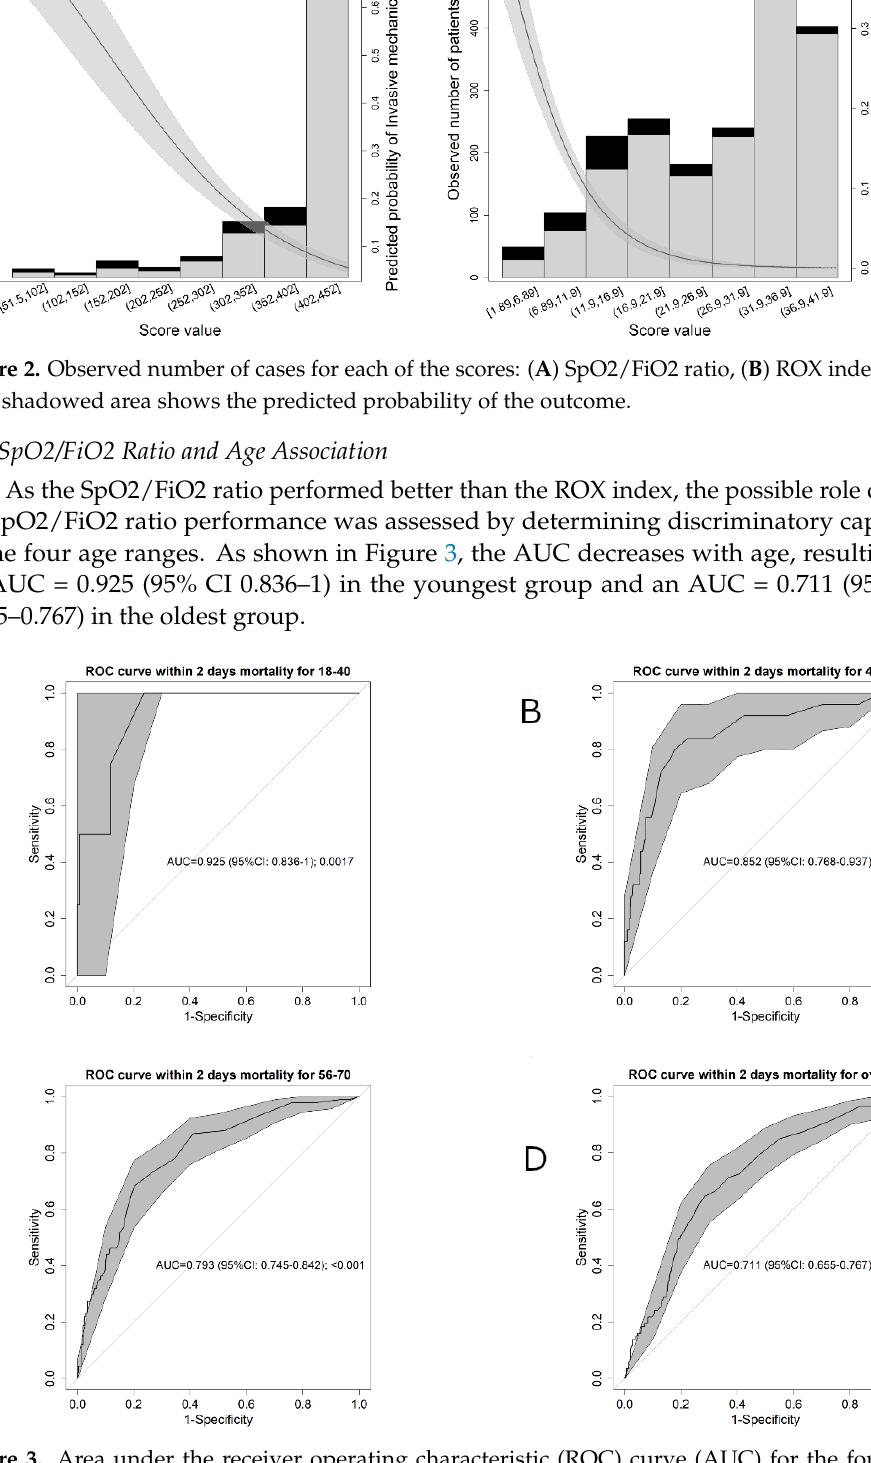
Figure 3. Area under the receiver operating characteristic (ROC) curve (AUC) for the four age ranges: ( A ) <40, ( B ) 41 – 55, ( C ) 56 – 70, ( D ) >70. The grey shadowed area shows the confidence interval (95% CI). ranges: ( A ) <40, ( B ) 41–55, ( C ) 56–70, ( D ) >70. The grey shadowed area shows the confidence interval (95%